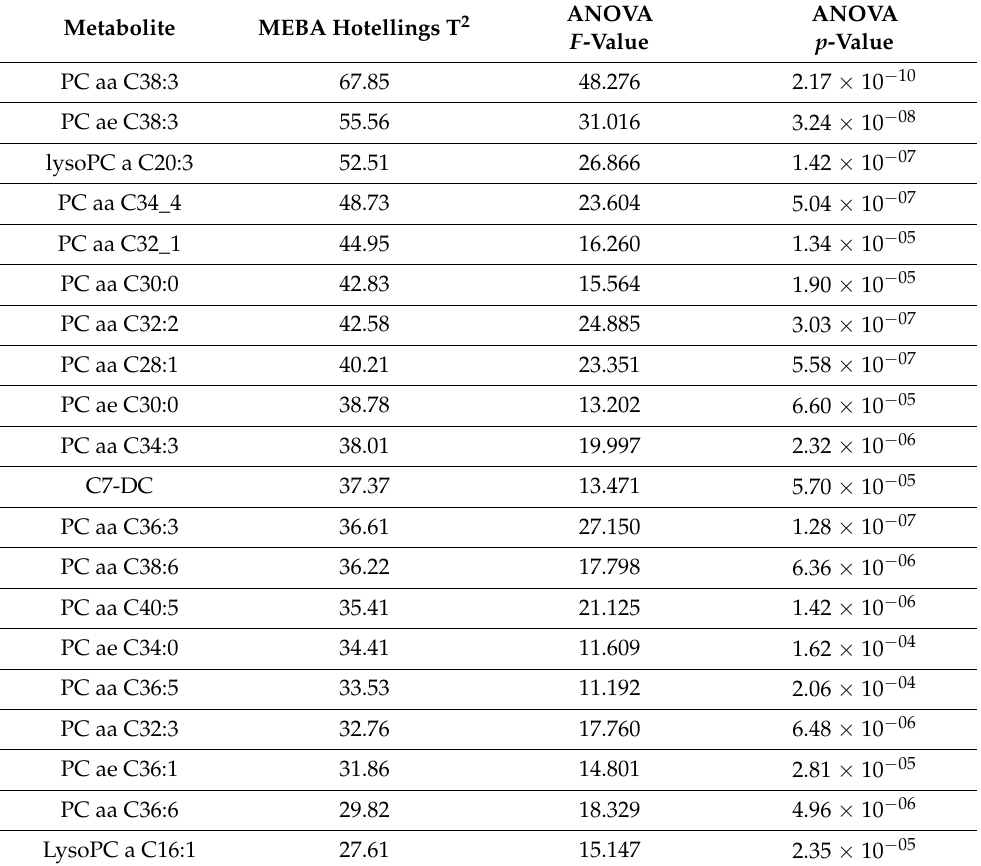
Table 4. Results of time-course analysis (MEBA and two-way repeated ANOVA; significance thresh- old p = 2.16 × 10 − 4 ): Table 2. are listed. Two examples revealing heterogeneity: glutamic acid and tryptophan (see Figure